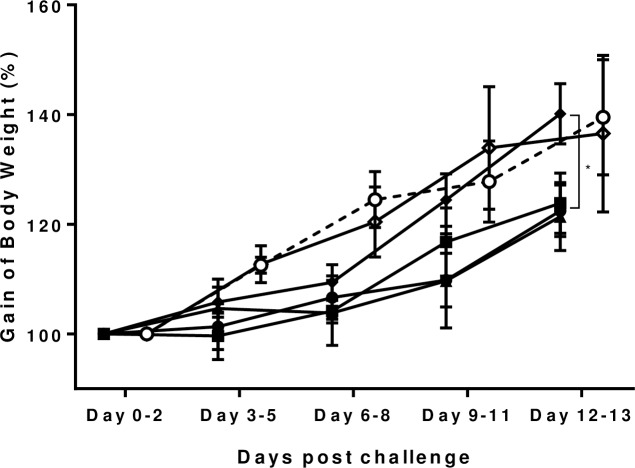
Gaining of body weight after drug treatment for C. hominis-infected piglets.Gnotobiotic piglets were inoculated orally with C. hominis oocysts two days after birth and treated with AZR, NTZ, or combined AZR and NTZ three days post challenge. Body weight was measured daily. Two-way ANOVA with Tukey’s multiple comparisons test was conducted using Graphpad Prism 7.01. * p<0.05. C. hominis TU502-infected group (n = 7, closed circle ●); TU502-infected, AZR-treated group (n = 3, closed squire ■); TU502-infected, NTZ-treated group (n = 3, closed triangle ▲). The partial measurement from a piglet, which was dead on day 8 post NTZ treatment were included; TU502-infected, AZR+NTZ-treated group (n = 7, closed rhombus ◆); Uninfected, AZR+NTZ treated group (n = 3, open rhombus ◇); and untreated control group (n = 2, open circle ○). The C. hominis TU502-infected group and untreated control group already shown in Fig 1 were added for comparison. The measurement of body weight from experiment I, II, and III was excluded due to the inaccuracy of scale.